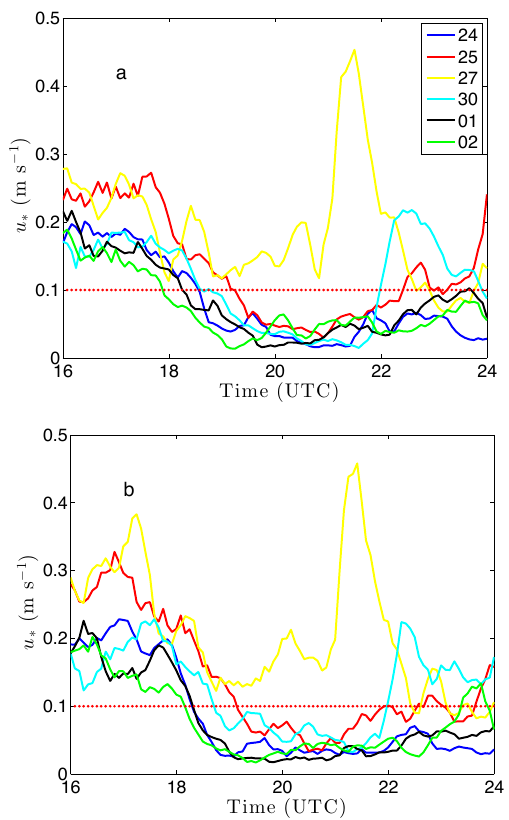
Figure 6. Temporal evolution of u ∗ from 16:00 to 24:00 UTC on all the studied days at (a) T1 and (b)